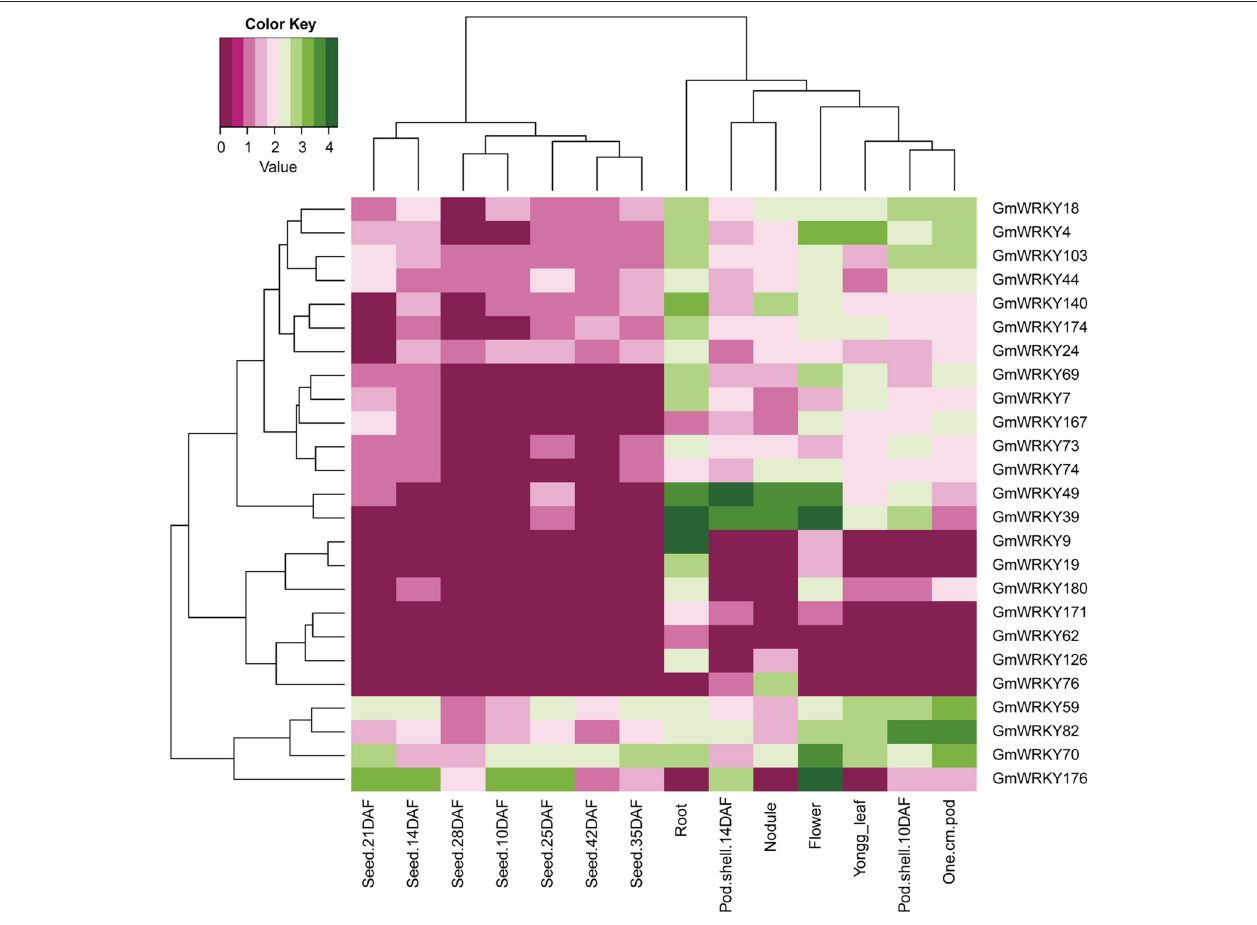
FIGURE 5 | Expression pattern of GmWRKY group I genes in different tissues. The Reads/Kb/Million (RPKM) normalized values of expressed genes was log 2 -transformed. The abbreviation “DAF” in the tissue label indicates “Days after